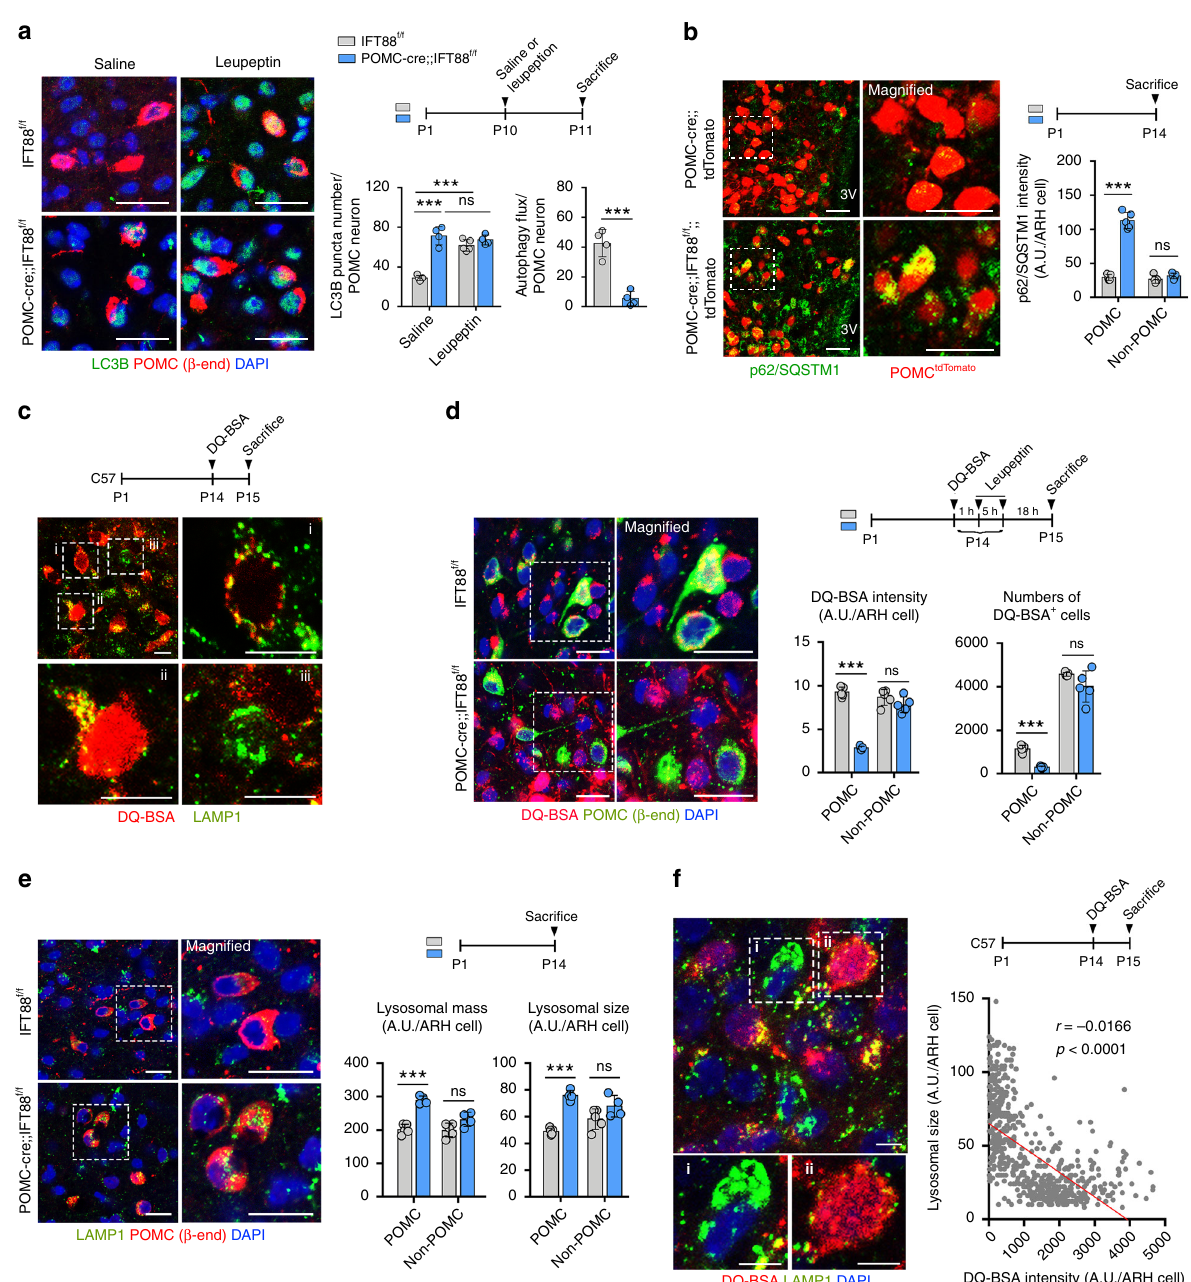
Fig. 6 Lysosomal dysfunction in the POMC neurons with defective ciliogenesis. a LC3B (autophagy marker), β -endorphin ( β -END), and DAPI staining for autophagy analysis in the ARH of POMC-cre;;IFT88 f/f and IFT88 f/f neonates at P11 ( n = 5 for saline, n = 4 for leupeptin each genotype). Scale bars: 20 μ m. b p62 (autophagy substrate) and tdTomato costaining in the ARH of POMC-cre;;IFT88 f/f ;;tdTomato and POMC-cre;;tdTomato neonates at P14 ( n = 5). The graph depicts the average fl uorescence intensity of p62 in 100 cells per mouse. Scale bars: 20 μ m. c Double staining of DQ-BSA, indicative of lysosomal protein degradation, and LAMP1 in the ARH of C57 mice ( n = 6). Magni fi ed images of (i) ARH cell with DQ-BSA signals merged with lysosomes, (ii) cell with high-intensity lysosomal and extralysosomal DQ-BSA signals, and (iii) cell with lack of DQ-BSA signals. Scale bars: 10 μ m. d Double staining of DQ-BSA and β -END in the ARH of POMC-cre;;IFT88 f/f mice and IFT88 f/f littermates ( n = 5). The average DQ-BSA intensity values in 100 cells and the numbers of DQ-BSA + cells in the ARH are presented. Scale bars: 20 μ m. e LAMP1 and β -END double staining showing lysosomal mass and sizes in POMC and non-POMC ARH cells at P14 ( n = 4 for POMC-cre;;IFT88 f/f mice, n = 5 for IFT88 f/f mice). The graph depicts the average values of LAMP1 intensity (lysosomal mass) and LAMP1 + puncta size (lysosomal size) in 100 cells per mouse. Scale bars: 20 μ m. f Double immunostaining of DQ-BSA and LAMP1 in the ARH cells of C57 mice ( n = 6). Magni fi ed images of (i) ARH cell with larger lysosomes and lower DQ-BSA fl uorescence intensity and (ii) cell with smaller lysosomes and higher DQ-BSA intensity. The graph depicts the correlation between the average lysosomal size and DQ-BSA intensity in ARH cells. Scale bar: 5 μ m. Data values are presented as mean ± SEM. Statistics were performed using two-sided Student ’ s t test ( a — autophagy fl ux, b , d , e ), one- sided one-way ANOVA followed by post hoc LSD test ( a — LC3 puncta), and linear regression analysis ( f ). *** p < 0.001 between groups. ns not signi fi